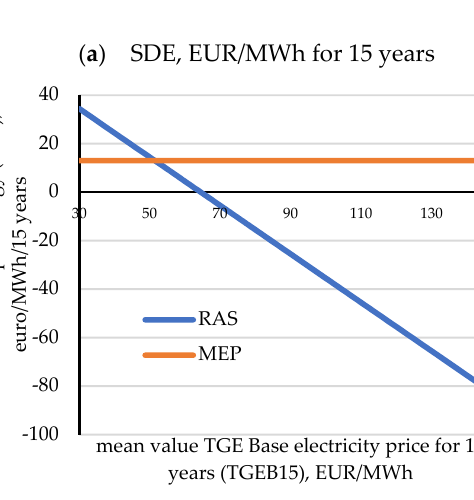
Figure 12. The balance curve between the negative and positive balance (RAS) compared to the My Electricity Program: ( a ) converted into the amount of energy produced for 15 years—SDE, ( b ) converted into installed capacity (GWp)—SDC. Although the MEP is not price dependent, it was advisable to plot the results (in the form of SDE and SDC) for the MEP to show the intersection between the MEP and RAS curves, i.e., at a price of around EUR 51.8/MWh. SDE(RAS) = 0 for TGEB15 = RASp = EUR 63/MWh. SDC(RAS) = 0 for TGEB15 = RASp = EUR